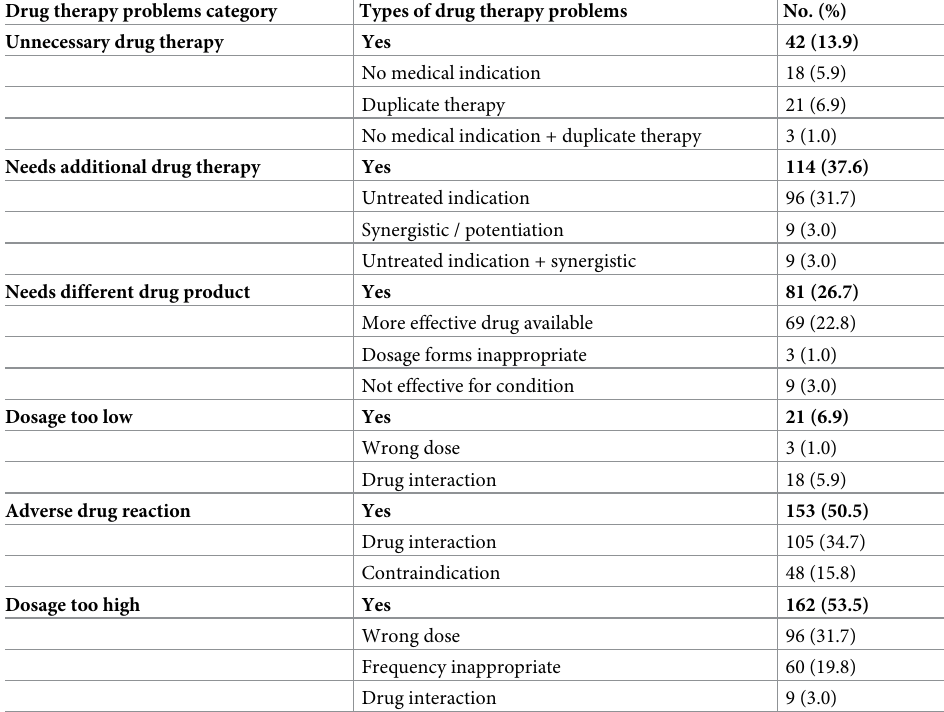
Table 4. Types of